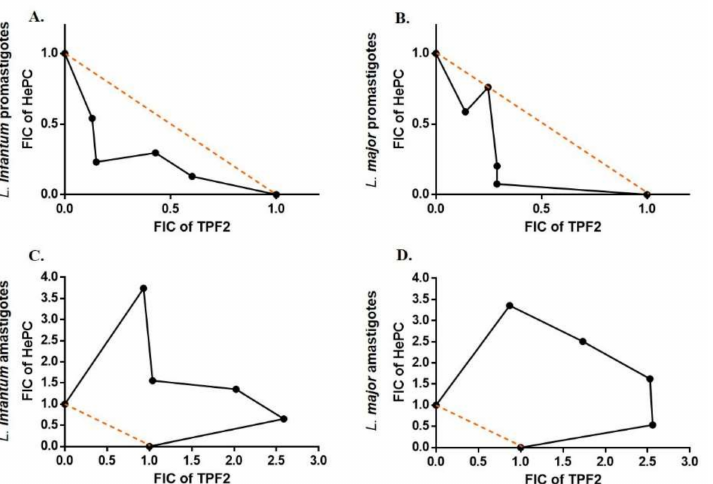
Figure 9. Representative normalized isobolograms of the interaction of TPF2 and HePC. Drug interaction was analyzed against L. infantum ( A , C ) and L. major ( B , D ) promastigotes and intracel- lular amastigotes. Numbers on the axes represent normalized FICs of TPF2 ( x -axis) and HePC ( y -axis). Data points (dots) located above, on, or below the line indicate antagonism, additivity, or synergy, respectively. The constructed isobolograms are the result of three independent experiments run in